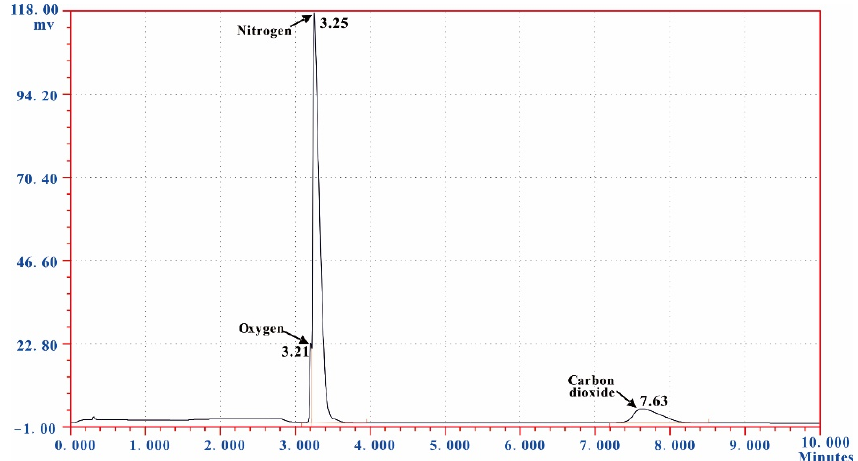
Figure 6. Analysis results of gas components collected after the reaction.